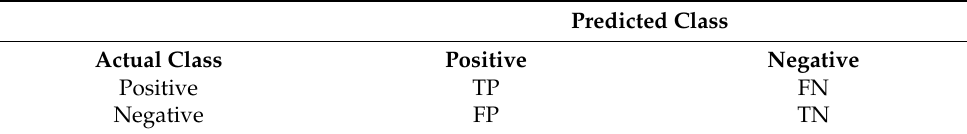
Table 8. Confusion Matrix.